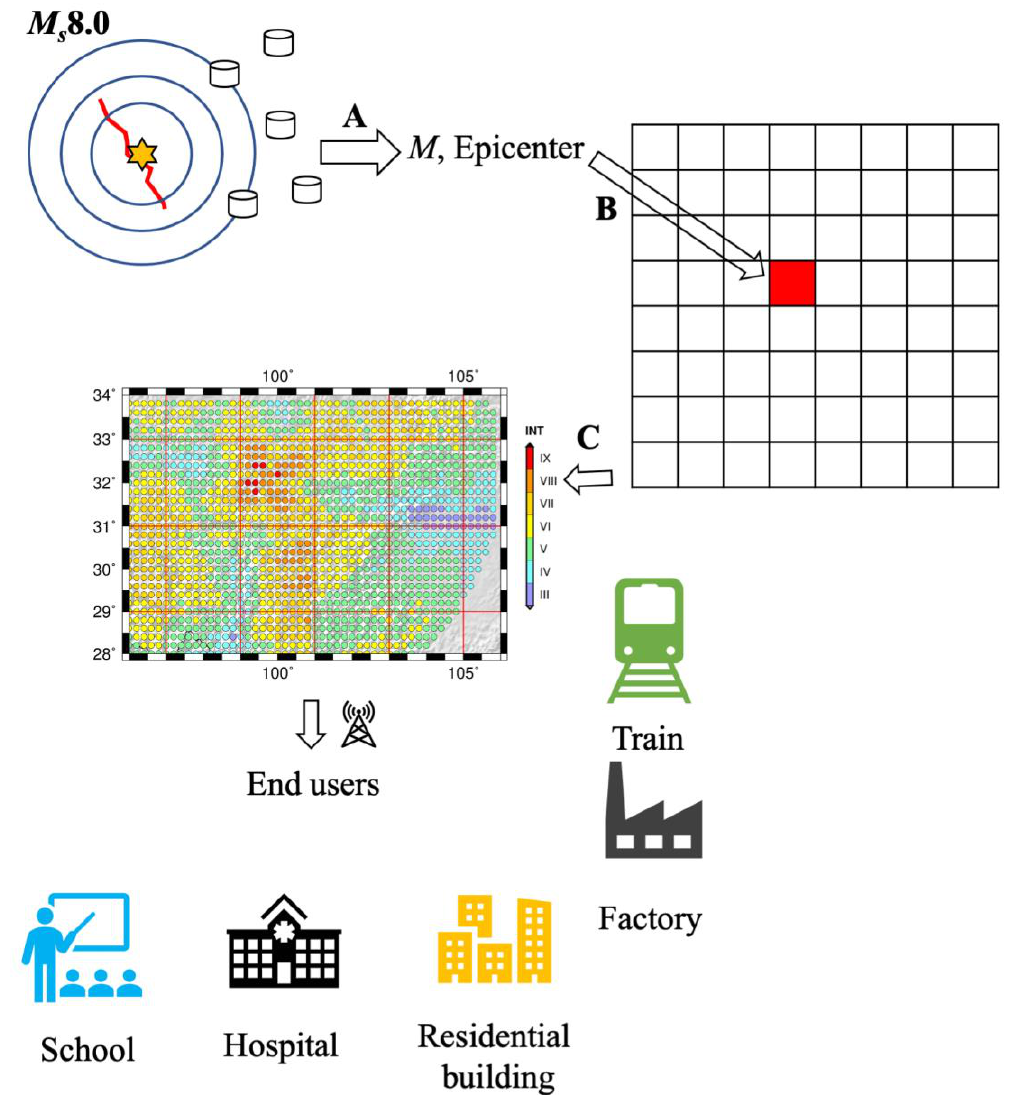
Figure 13. One possible application scenario of MMI database: ( A ) Fast estimation of magnitude and epicenter; ( B ) fast matching of the cell including the epicenter and the magnitude class; ( C ) extraction from the MMI database of the pertinent MMI maps and issue of the warning to different end users, e.g., school, hospital, residential building, factory, and train.